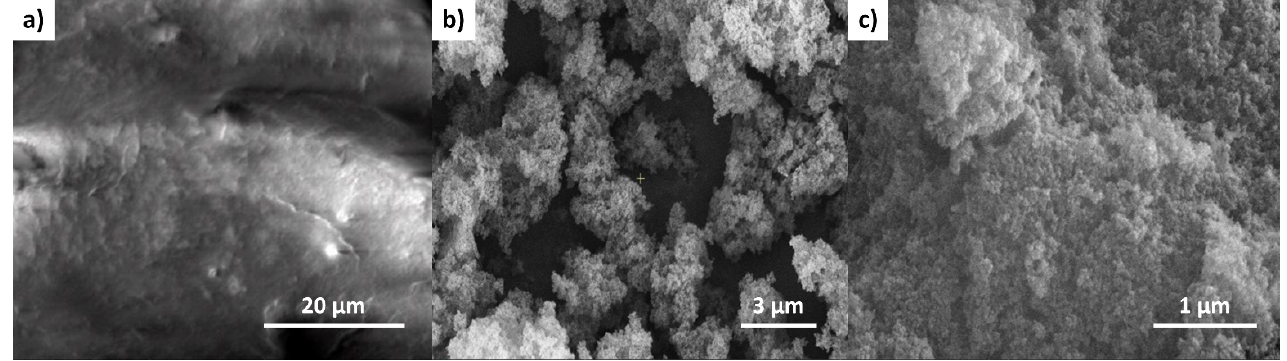
Figure 3. SEM images of POP2 taken at different magnification, ( a ) 20 μm, ( b ) 3 μm, and ( c ) 1 μm.